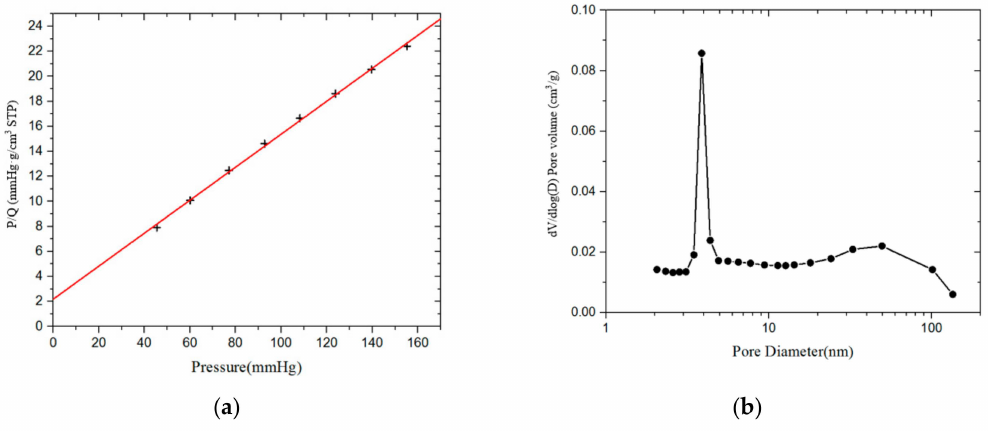
Figure A4. Nitrogen adsorption of sample 2 measured by an ASAP 2420 instrument (Micromeritics). ( a ) Langmuir surface area plot. ( b ) BJH desorption dV / dlog(D) pore